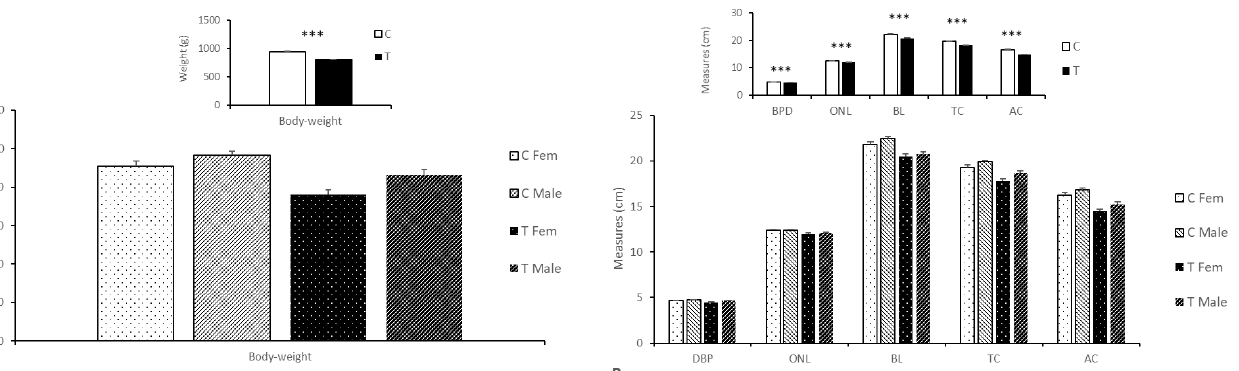
Table 2. Mean (± S.E.M.) values of weight of different body parts and major organs and their ratios at Day 100 of gestation in different treatments (fetuses from control sows, Group C and from sows treated with hydroxytyrosol, and n-3-PUFA from Day 35 to Day 100 of gestation (Group T) and by litter sizes (small ≤ 9 fetuses, large > 9 fetuses). Treatment Litter Size Control Treated Small Large